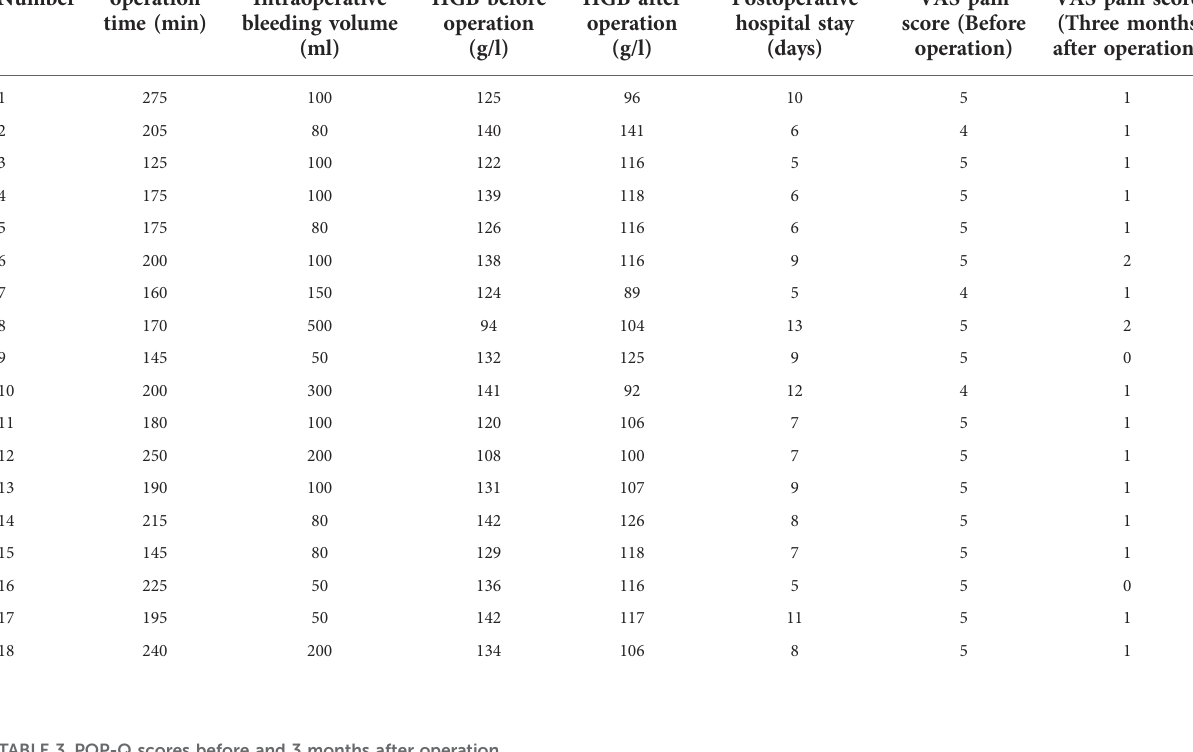
TABLE 2 Information related to patients ’ surgery.